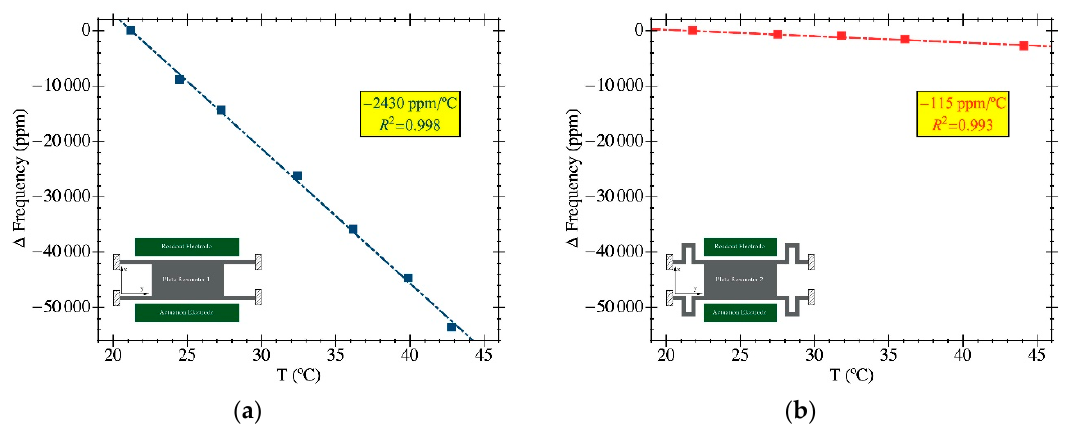
Figure 12. Resonant frequency dependence versus operation temperature calibrated into a climate chamber where the RH has been kept at 40 ± 1% for the whole curve. The DC bias voltage is 30 V for both resonators: ( a ) PR1; ( b ) PR2. Both plots preserve the same vertical scale in order to obtain a fairer visual comparison.